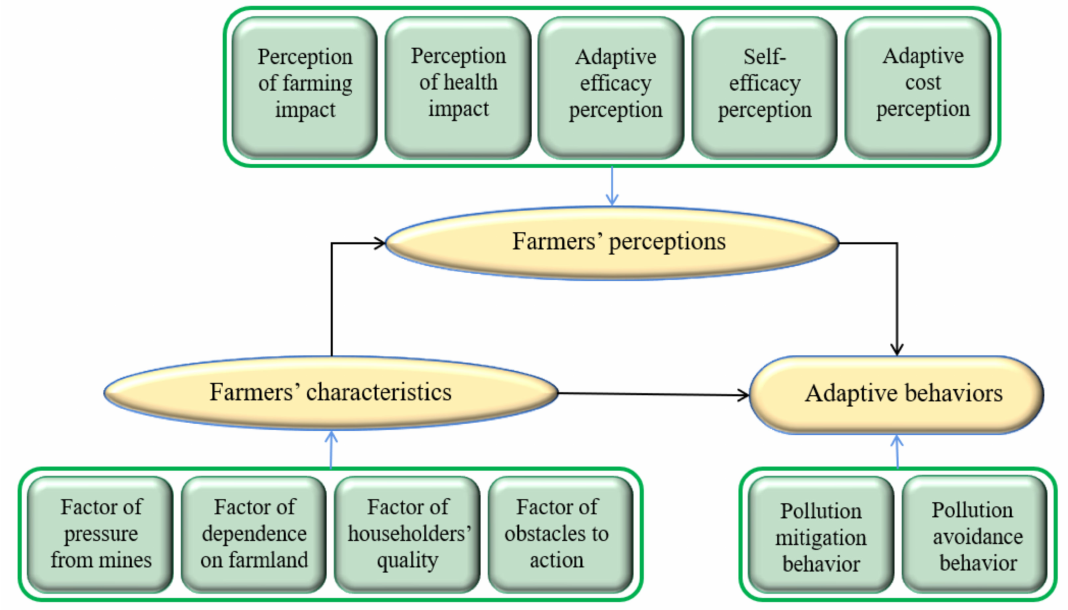
Figure 1. Conceptual framework of “farmers’ characteristics-perceptions-adaptive